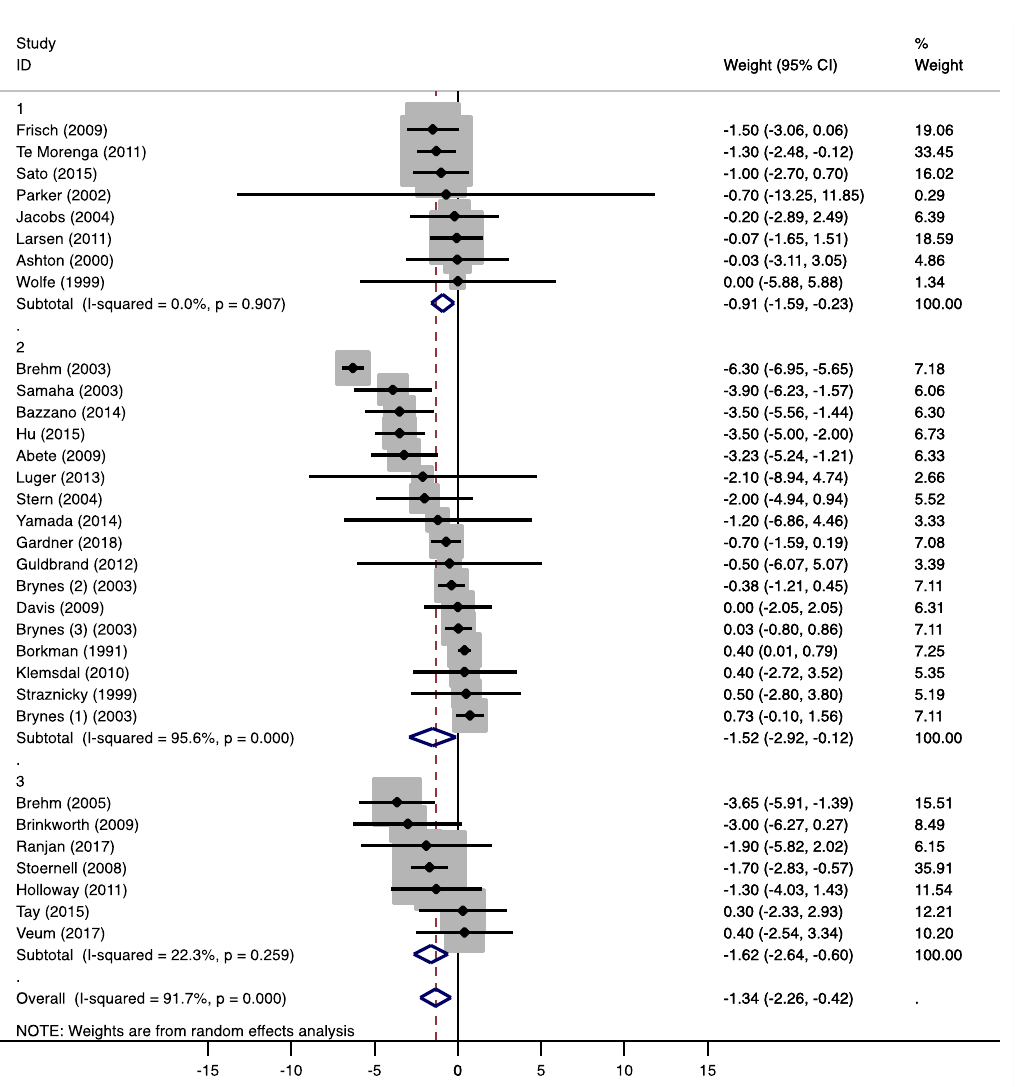
Figure 2. Forest plots of randomized controlled trials that examined the e ff ects of carbohydrate (CHO) restriction on body weight changes. Studies were categorized in group 1 (moderate-low CHO, 40–45 E%), group 2 (low CHO, 40–30 E%), and group 3 (very-low CHO, 30–3 E%). Solid squares represent the weight of individual studies and diamonds represent the weighted mean di ff erence (WMD) in weight change. E ff ects were calculated using random-e ff ect meta-analysis. No significant di ff erences in body weight changes were detected between the low-carbohydrate diet (LCD) groups. The moderate-low CHO diets did not result in significant changes in total cholesterol ( − 0.05 mmol / L, 95% CI − 0.19 to 0.08 mmol / L, p = 0.413, Supplementary Figure S1A) and LDL-C (0.01 mmol / L,